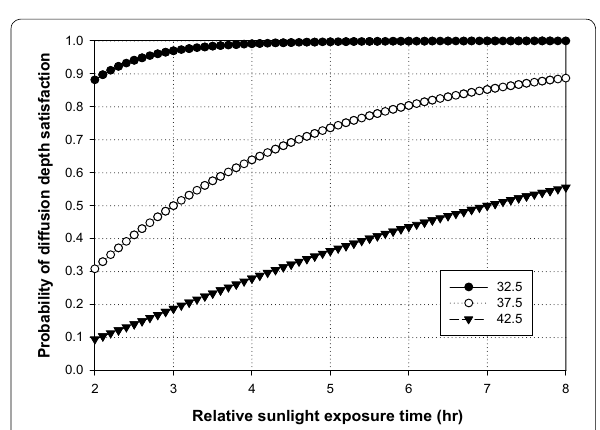
Fig. 10 Satisfaction Curve of sunlight exposure time parameter for combine chloride diffusion depth rate (32.5, 37.5, 42.5).